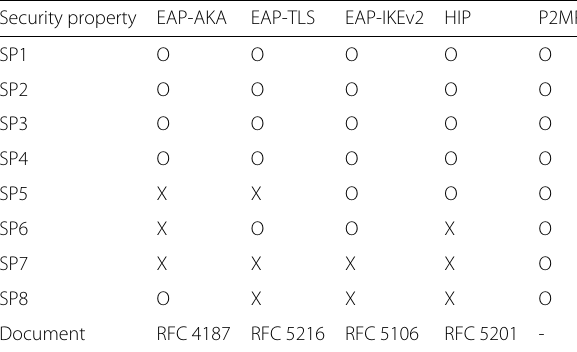
Table 5 Comparison of protocols by security